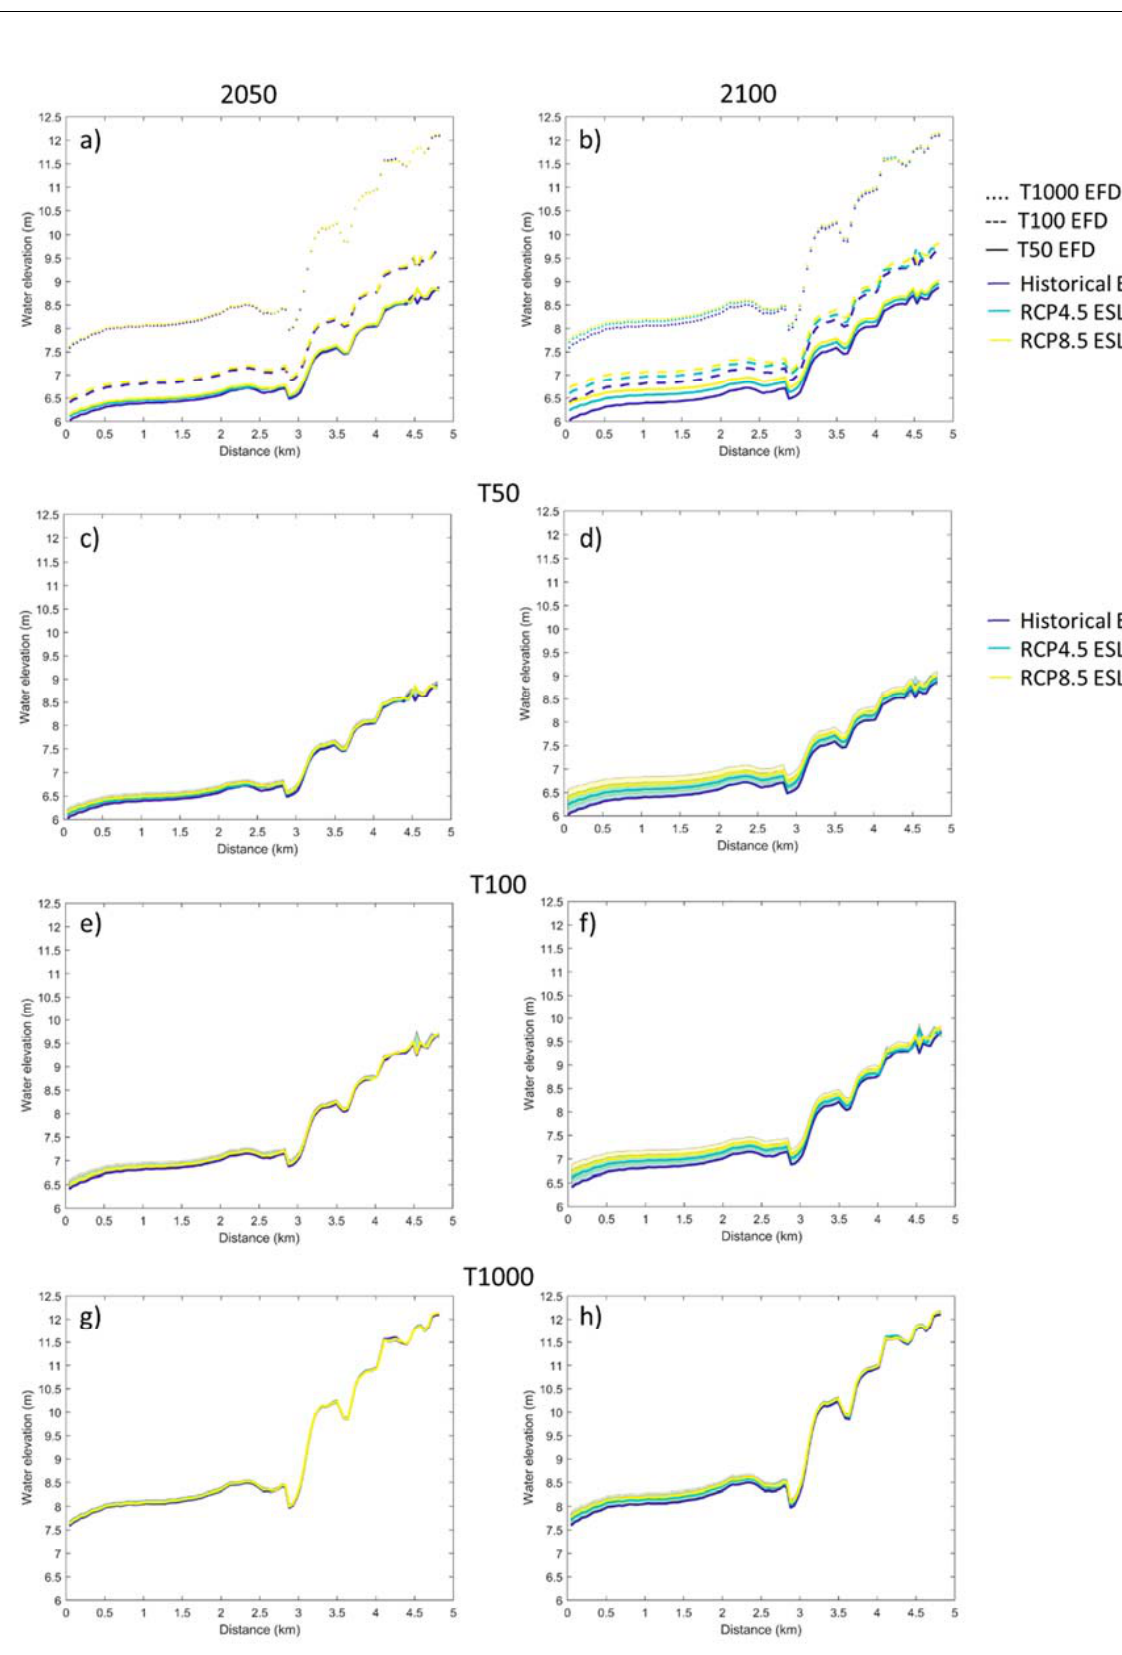
Figure 2. Longitudinal profiles of the superensemble solutions that represented the water level along the Douro estuary for the considered scenarios. ( a , b ) For average values of the water elevations at the ocean boundary; ( c – h ) Considering the maximum and minimum water elevations values at the ocean boundary to represent the probability forecast.